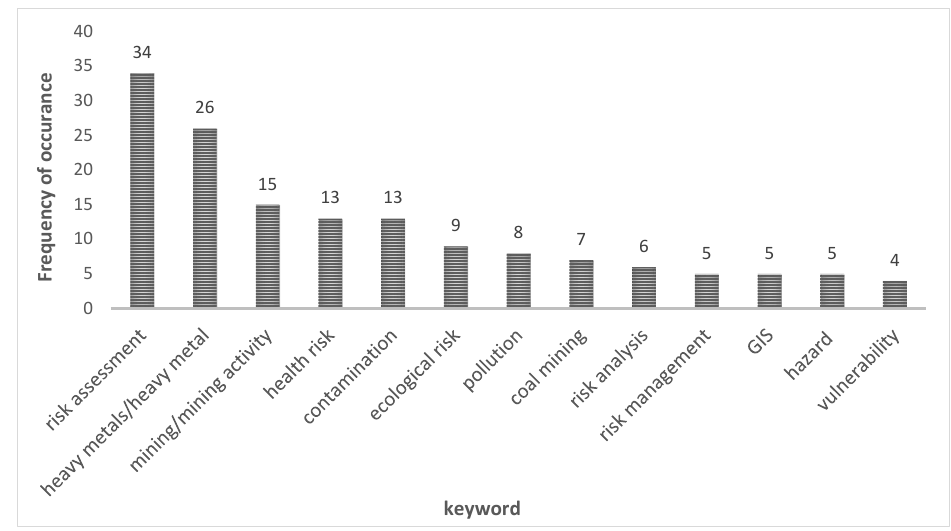
Figure 7. Number of most frequently occurring keywords in the analyzed papers.